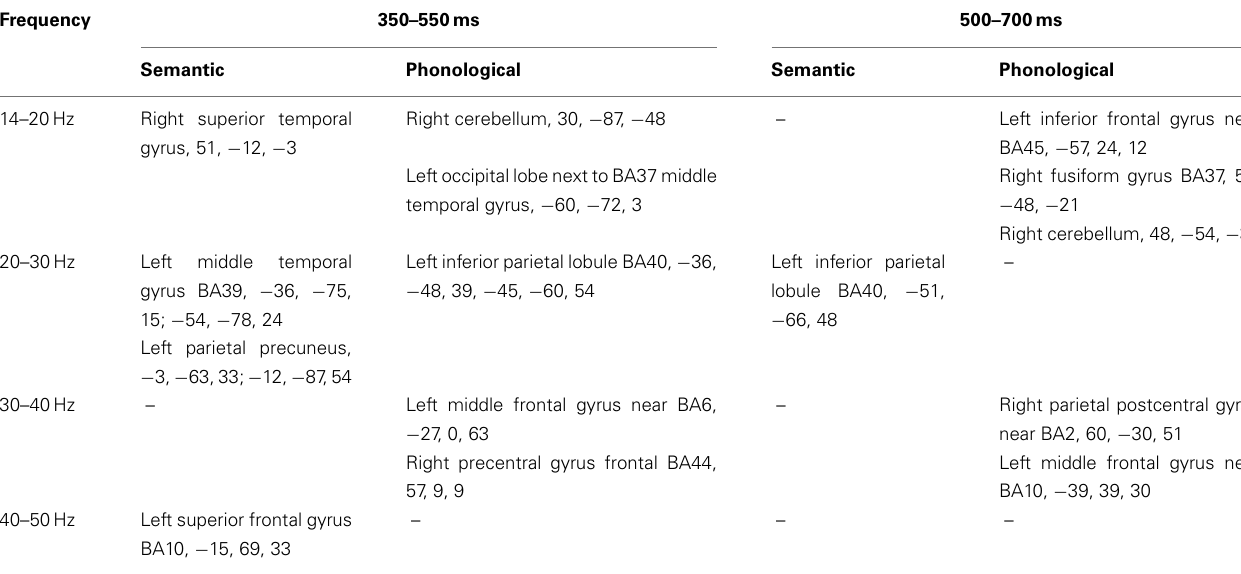
Table 1 |The co-ordinates of each of the peak voxels that showed significant effects ( p < 0.05, corrected) for the two task conditions relative to their respective prestimulus baseline, identified using Statistical Non-Parametric Mapping, for the two time